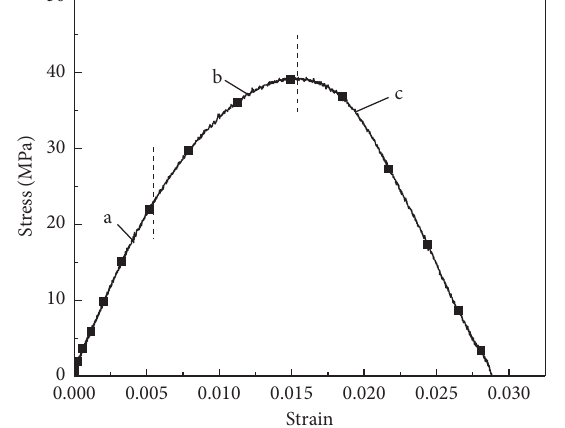
Figure 4: Stages of the dynamic stress-strain